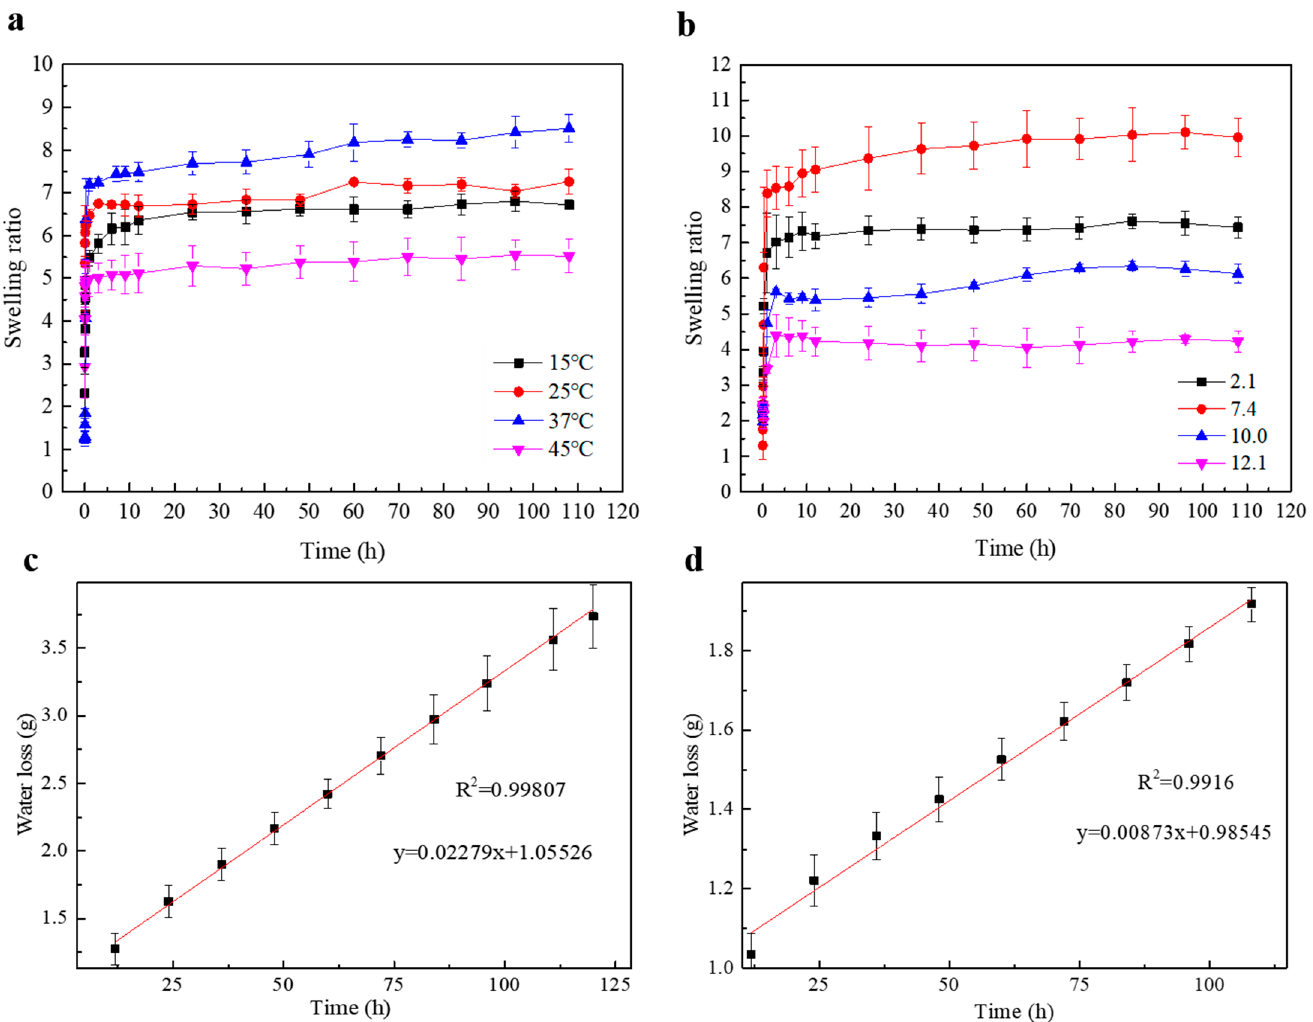
Figure 6. Swelling kinetics of SF/CMCS hydrogels at different temperatures ( a ) and pH values ( b ). Water vapor transmitted across the CMCS hydrogel ( c ) and SF/CMCS hydrogel ( d ).